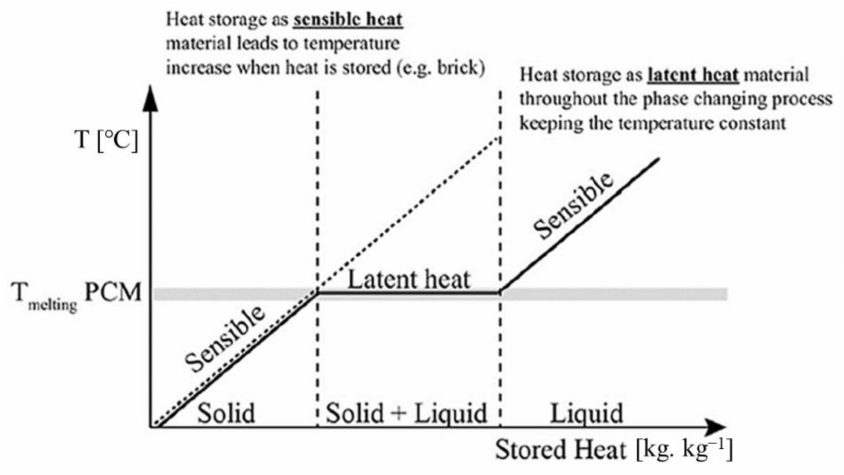
Figure 5. Latent heat storage for the case solid–liquid